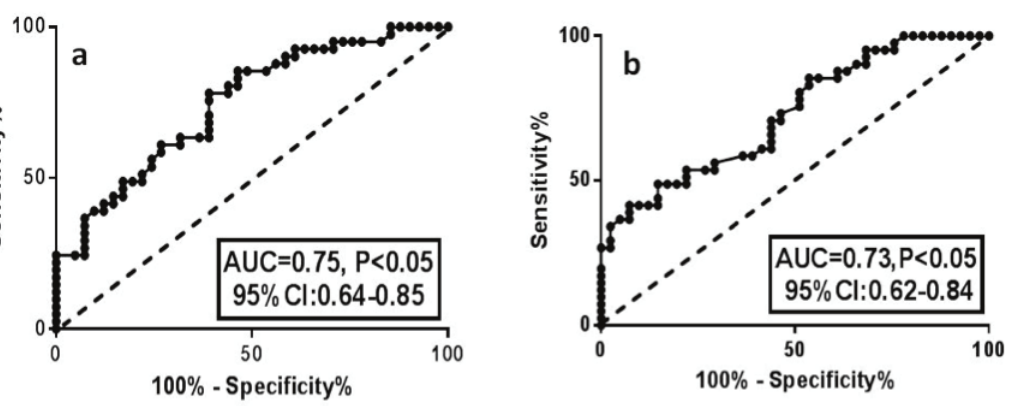
Figure 2: The ROC analysis show the sensitivities and specificities of serum miR-25 and CA19-9 for GC diagnosis (a: serum miR-25 for diag- nosis of GC; b: serum CA19-9 for diagnosis of GC).